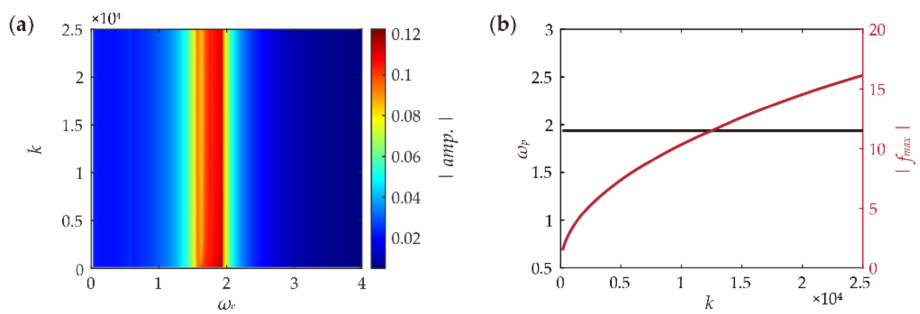
Figure 13. ( a ) Effects of constraint stiffness on the frequency responses of the resonant-impact DEA system and ( b ) effects of constraint stiffness on the peak frequency and peak impact